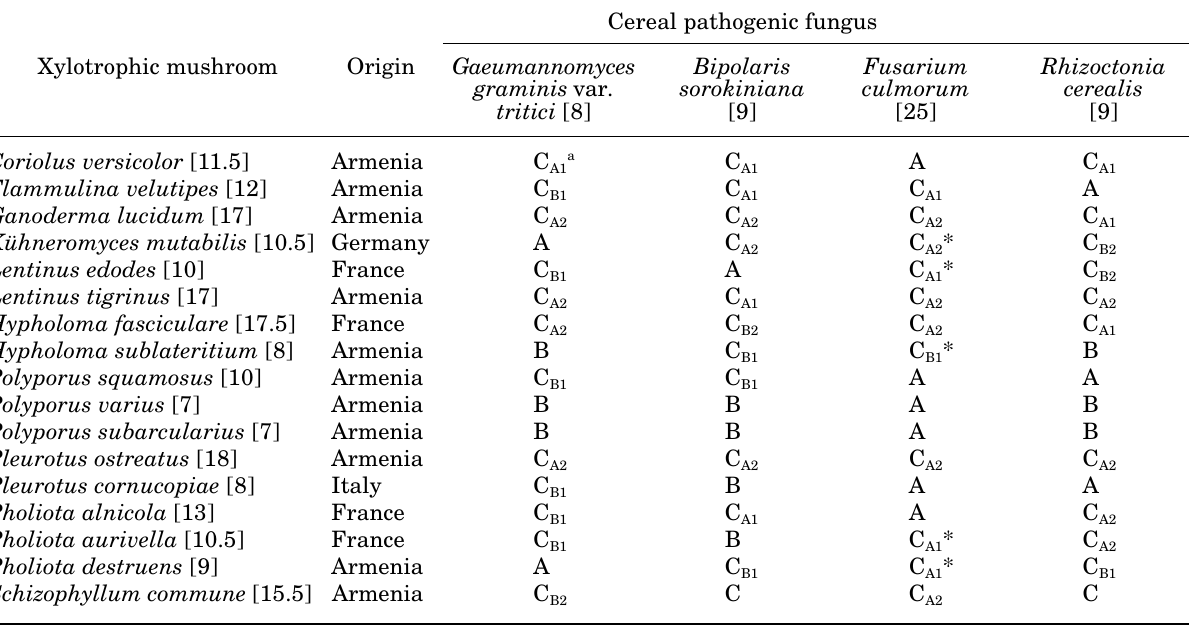
Table 1. Antagonism index values (in square brackets) and competitive reactions between mycelium of xylotrophic mushrooms and cereal pathogenic fungi in pairings on potato dextrose agar